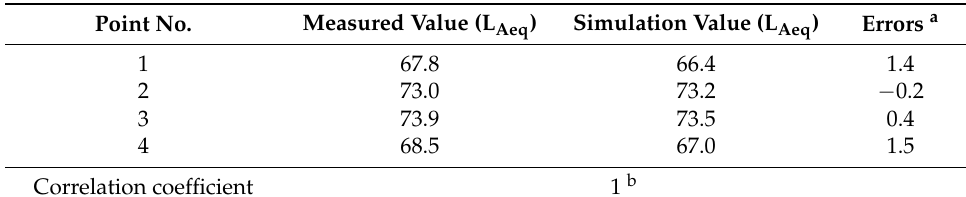
Table 6. Description of the noise data (unit: dB(A)) Point No.